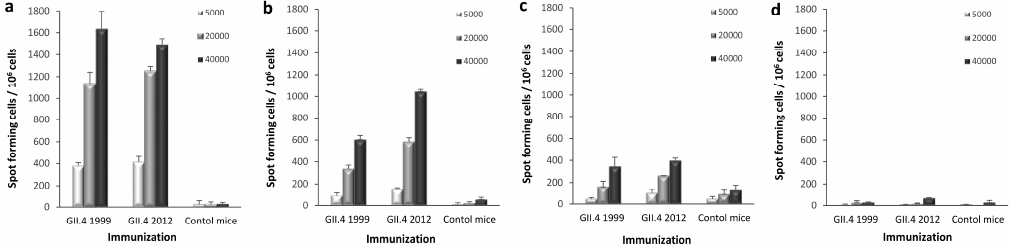
Figure 5. Norovirus (NoV) GII.4-specific T-cell responses. Group-wise pooled splenocytes of mice immunized with GII.4 1999 virus-like particles (VLPs), GII.4 2012 VLPs, or PBS only (control mice) were analyzed for interferon gamma (IFN- γ ) production by an ELISPOT assay. Increasing number (legend) of bone marrow-derived dendritic cells (BMDCs) pulsed with GII.4 1999 ( a ), GII.4 2012 ( b ), or GII.4 2006 ( c ) VLPs were used to stimulate the splenocytes of GII.4 1999 or GII.4 2012 VLP-immunized mice. Un-pulsed BMDCs ( d ) served as a negative control. Mean IFN- γ spot-forming cells per 10 6 live splenocytes of duplicate wells with standard deviations (error bars) are